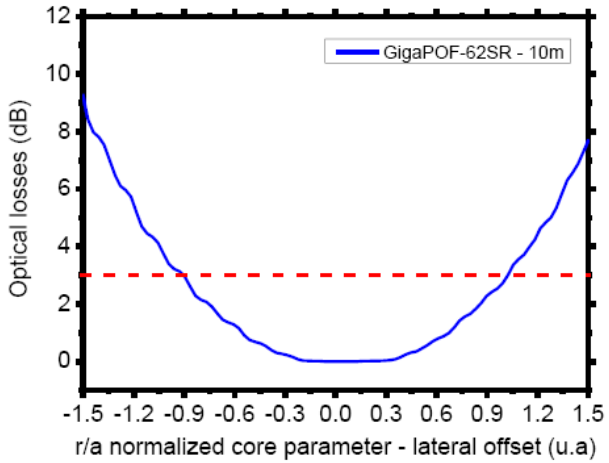
Figure 12. Optical losses measurement owing to a lateral offset.